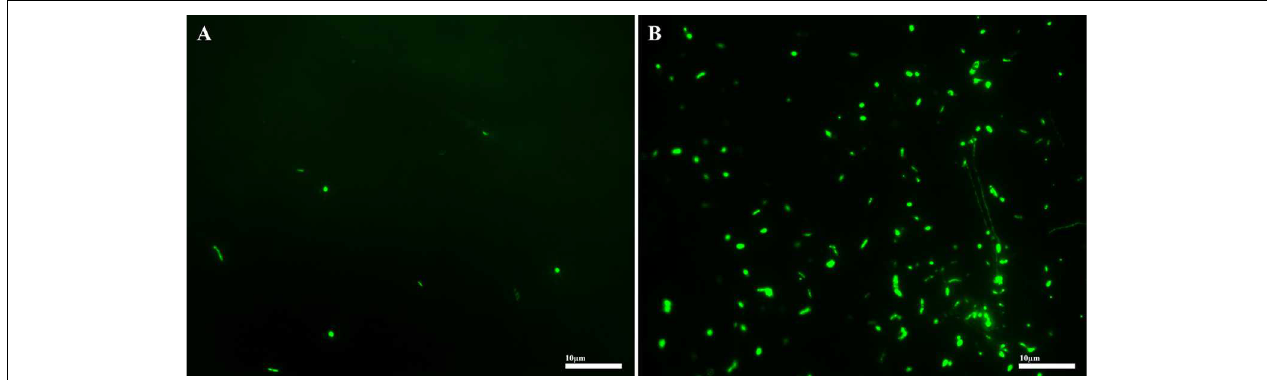
FIGURE 3 | Epifluorescence-microscopy image of basaltic crustal fluid samples from JFR filtered onto a Whatman 0.2 µ m Anodisc filter stained with SYBR Green I, before (A) and after (B) induction of spore germination by pasteurization and 48 h of incubation at 50 ◦ C. Scale bar 10 µ